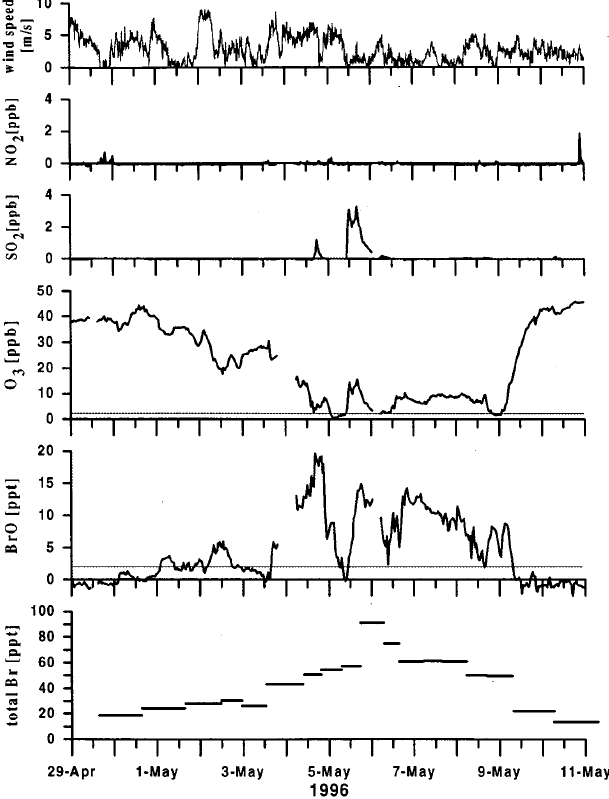
Fig. 7. The main ozone depletion event, ARCTOC 1996: mixing ratios of NO 2 , SO 2 , O 3 and BrO measured by DOAS together with wind speed at Zeppelin station (ARCTOC, 1997) and total bromine from neutron activation analysis